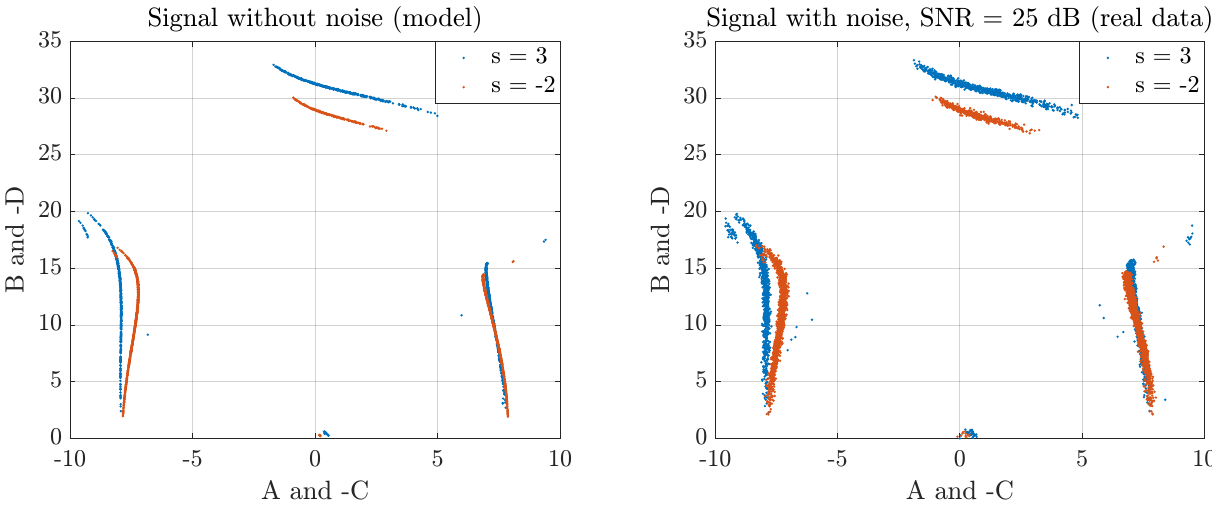
Figure 8. Return maps of the chaotic signal modulated with SCM technique.